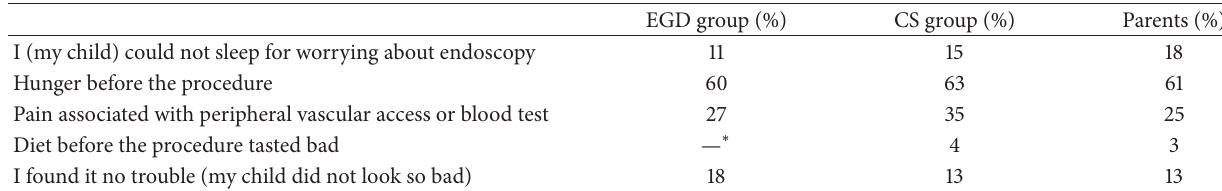
Table 3: Results of postendoscopy